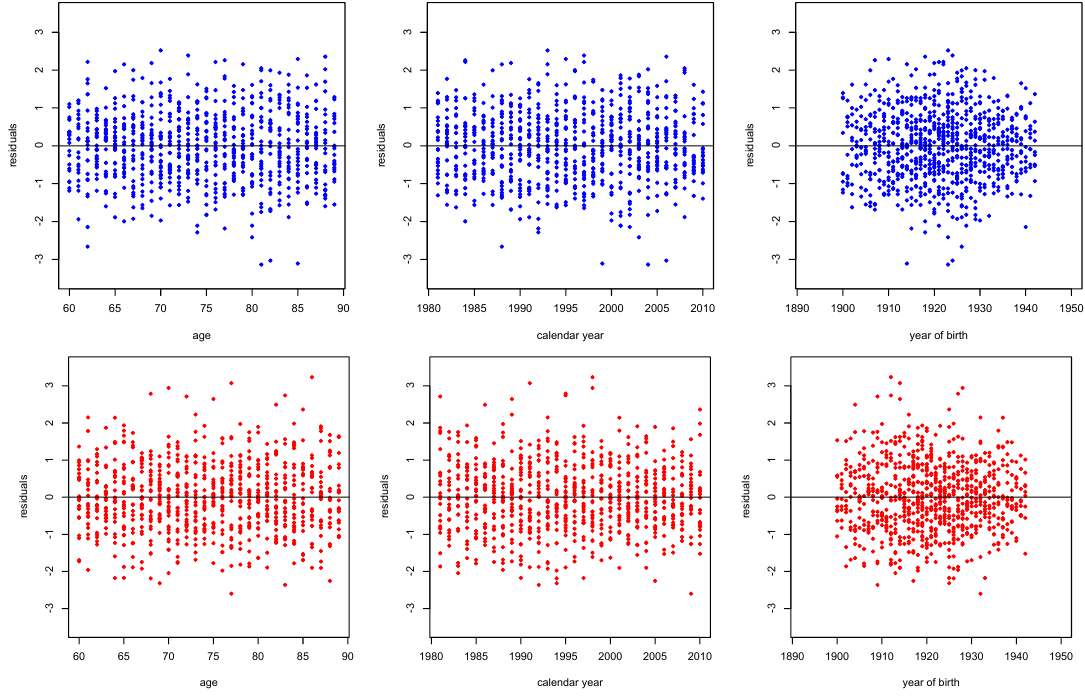
Figure 9. Residuals deviance of M 2 for males ( top panels) and females ( bottom panels) in Greece. Period 1981–2010, ages 60–89.